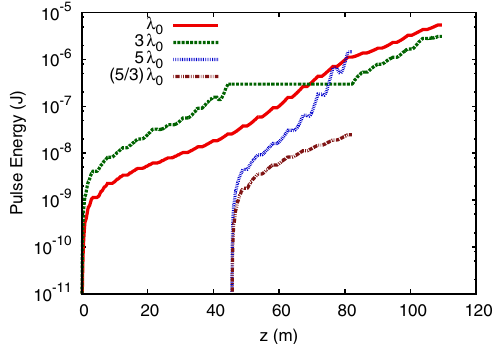
FIG. 22. Pulse energy produced at various wavelengths as a function of distance for the start-to-end bunch using a 3-stage configuration.